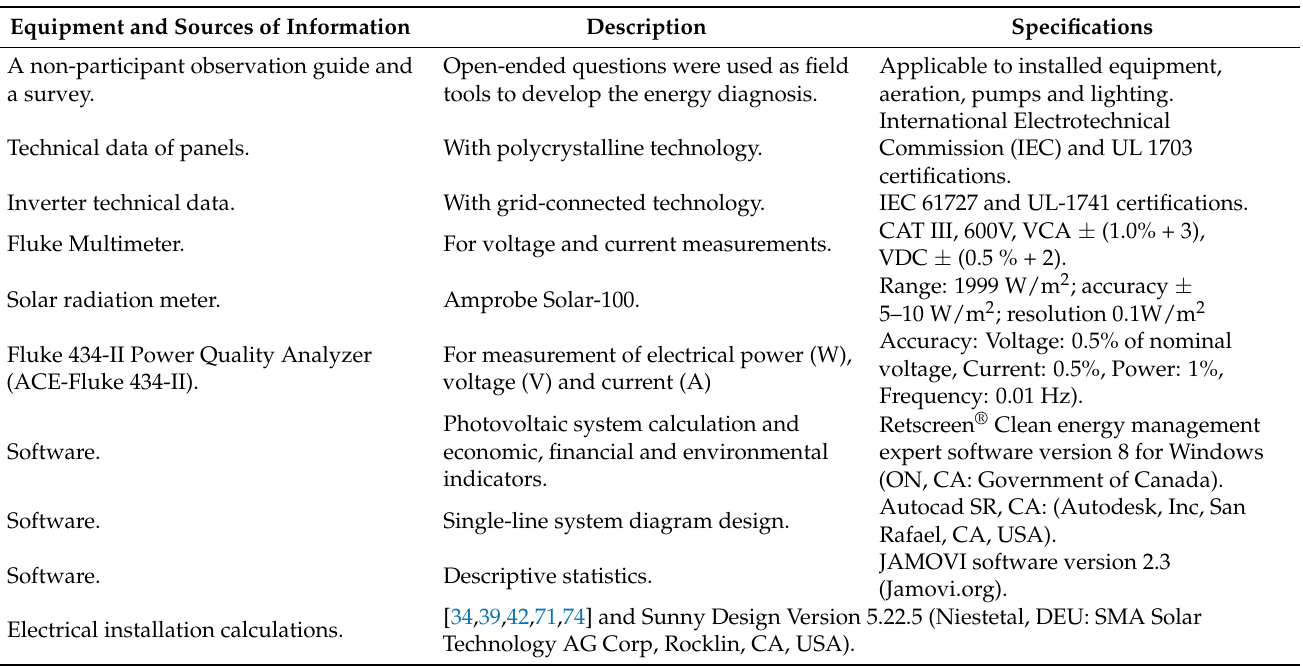
Table 2. The calculation and sizing of the On Grid-PV solar photovoltaic energy was carried out with the following